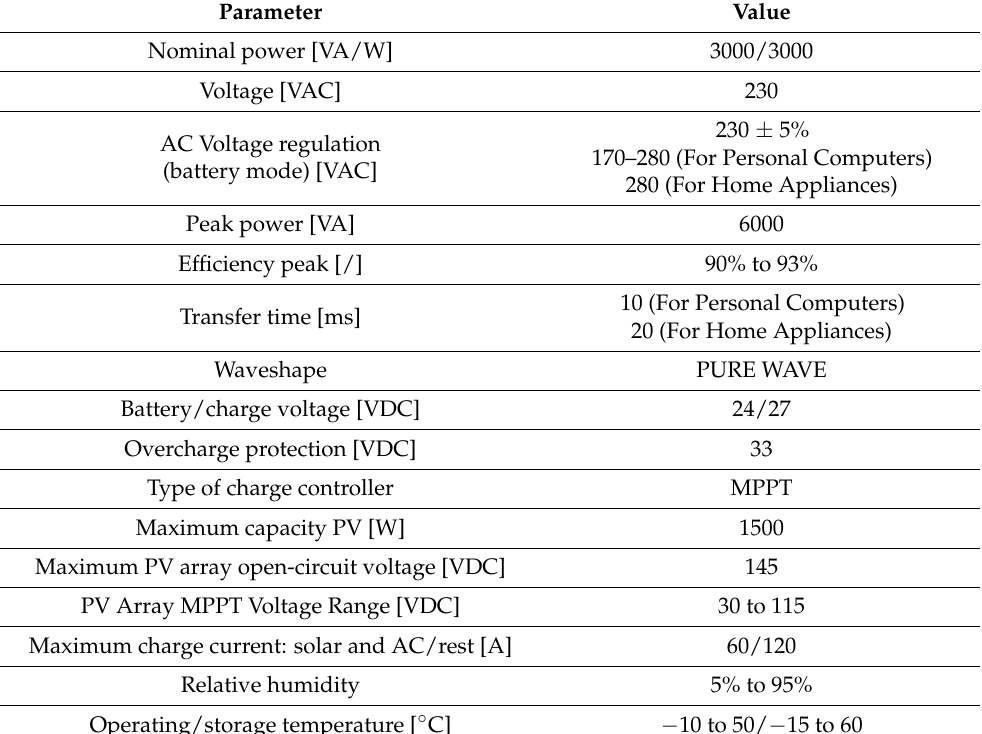
Table A4. Inverter characteristics.